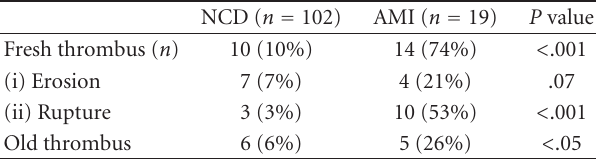
Table 1: Incidence of thrombosis in NCD and